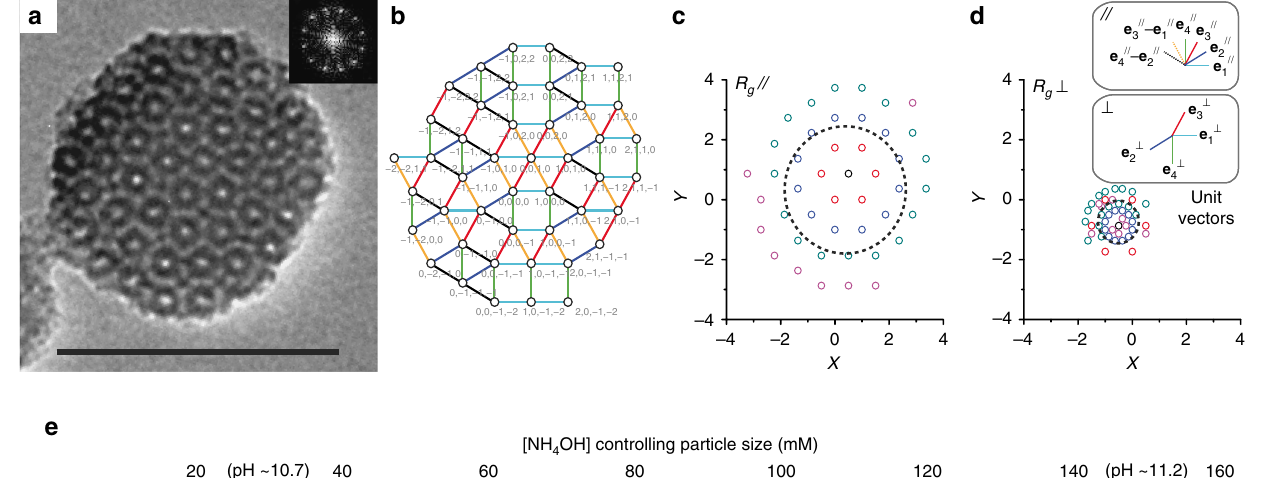
Fig. 3a – d. Micelle solutions prepared without TMB or using low [TMB] (4 mM) led to formation of hexagonal MSNs (Fig. 3k, l), whereas use of high [TMB] (72 and 116 mM) resulted in quasi- crystalline MSNs (Fig. 3m, n). Comparison of the entire series reveals that increasing [TMB] causes a shift to larger average micelle diameter as well as an increase in the positive skewness of the micelle size distribution, e.g., compare numbers of micelles with sizes above 5 nm as [TMB] increases (Fig. 3a – d).